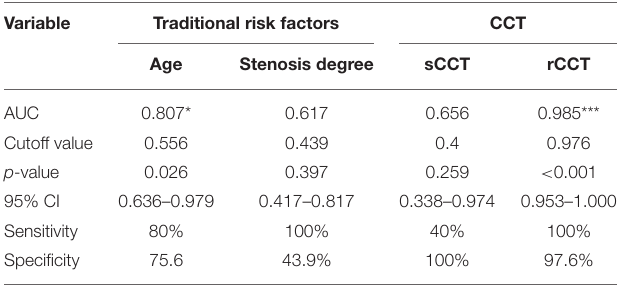
TABLE 3 | ROC curves for traditional risk factors and CCT in the prediction of disabling ischemic cerebrovascular events.